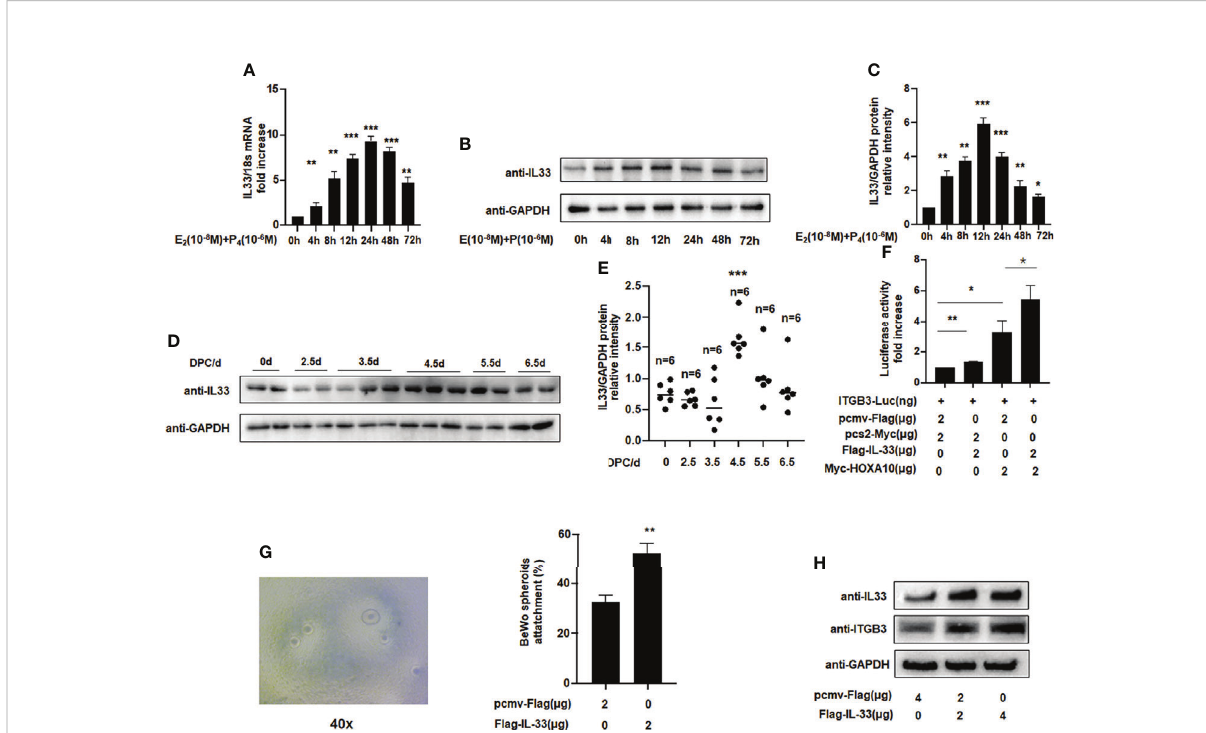
FIGURE 3 IL33 participates in embryo implantation. (A) Ishikawa cells were administered estrogen (10 – 8 M) and progesterone (10 – 6 M) at different times, as indicated. IL33 mRNA levels were measured by qRT-PCR. **p < 0.01, ***p < 0.001. (B) Ishikawa cells were administered estrogen (10 – 8 M) and progesterone (10 – 6 M) at different times, as indicated. Whole-cell lysates were analyzed by western blot analysis with the indicated antibodies. (C) Protein levels were normalized to GAPDH protein expression level in (B) (**p< 0.01, ***p < 0.001. vs control). (D) Western blot analysis of uterine IL33 during the peri-implantation period in mice, with the strongest decreased signal detected at 4.5 dpc. (E) Protein levels were normalized to GAPDH protein expression level in (D) (**p< 0.01, ***p < 0.001. vs control, n is shown in each group). (F) Ishikawa cells were transfected with ITGB3-Luc, Myc-HOXA10 (2 m g), and Flag-IL33 (2 m g), as indicated. After 48 h, the luciferase activities were measured and